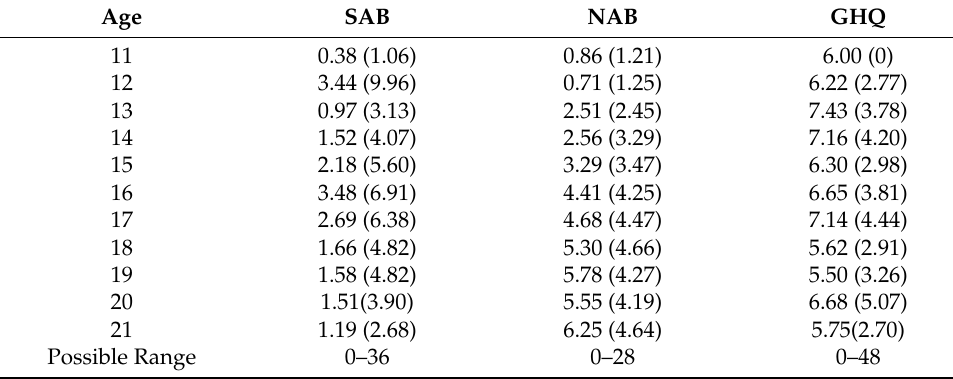
Table 1. Means, standard deviations and possible ranges for main study